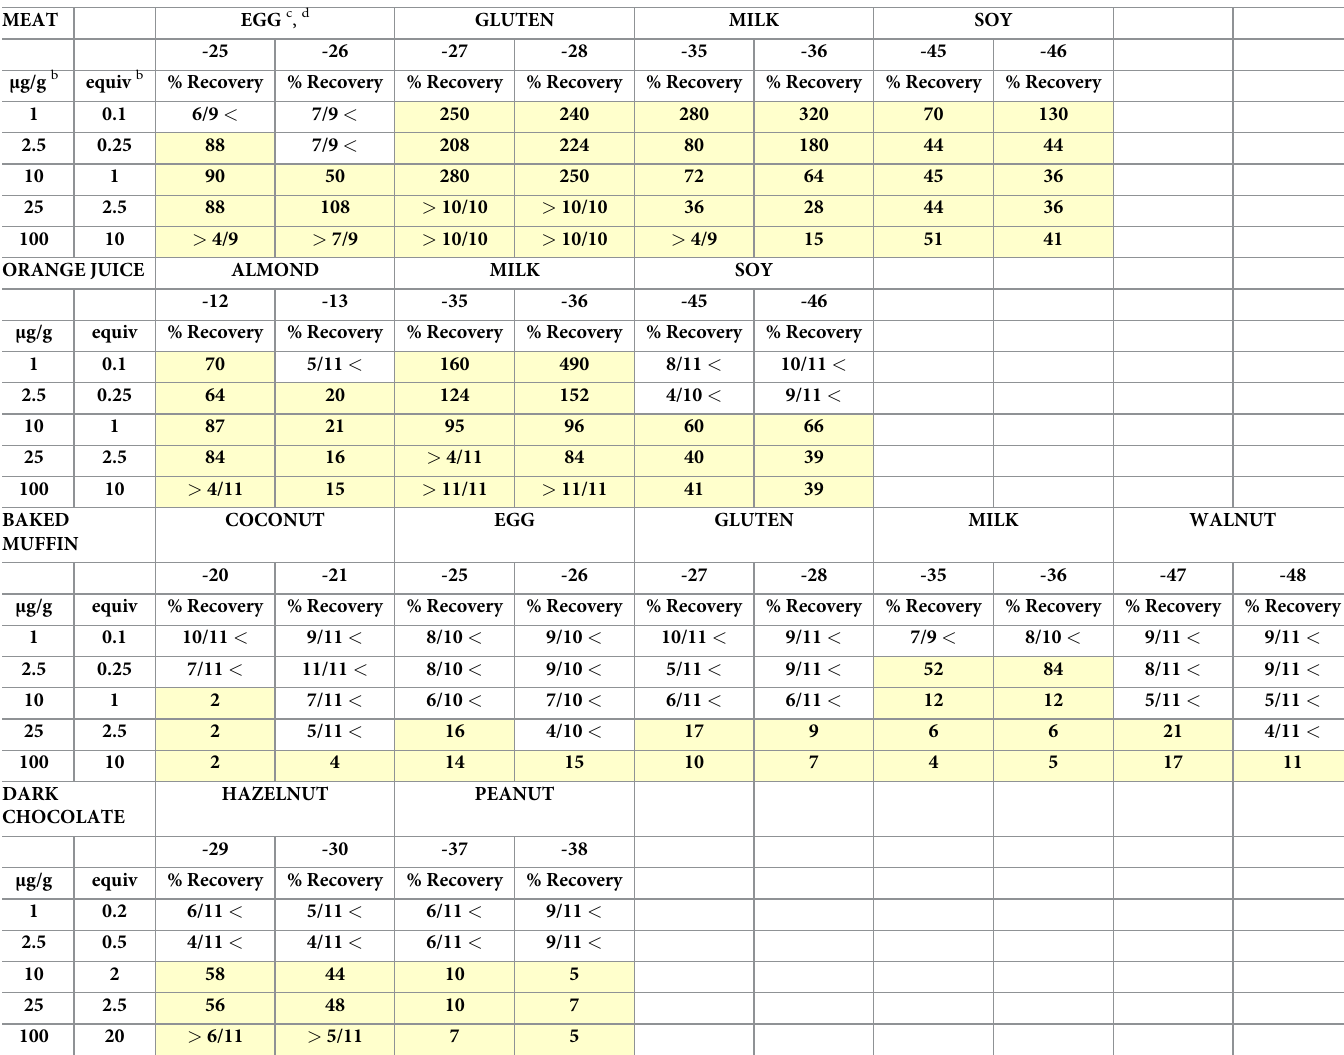
Table 16. Percent allergenic food recovered from food samples a